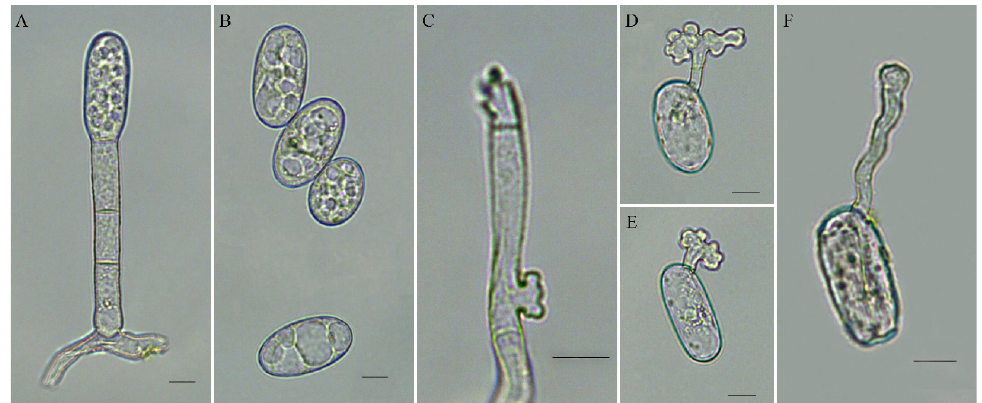
Figure 2. Morphology of Erysiphe vignae on common bean. ( A ) Conidiophore with attached conidium; ( B ) Conidia; ( C ) Hyphal appressorium; ( D ) and ( E ) Conidia with a germ tube germinating on a glass slide; ( F ) Conidium with a germ tube from diseased leaf; Bars = 10 μ m. After 48 h incubation of conidia on glass slides and the inner surface of petri dish lids, the lengths of germ tubes produced by 90% germinated conidia were shorter than or equivalent to that of conidia. The germ tubes grew from the terminal or near terminal of the conidia, and the apices of germ tubes were lobed or multi-lobed (Figure 2D,F). This result indicated that the conidia of isolate CBPM1 germinated the Pseudoidium -type germ tubes.